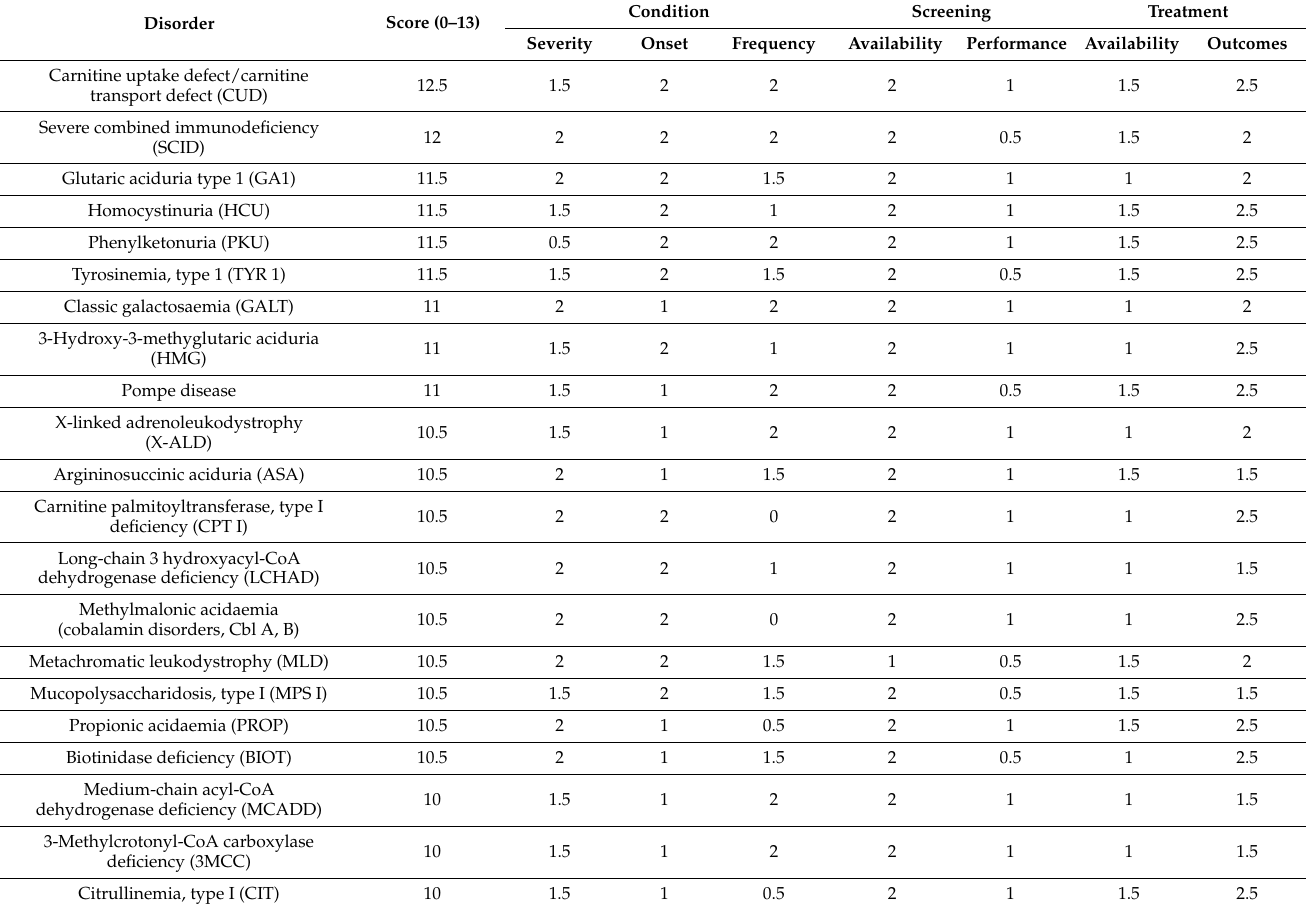
Table 1. Scoring of IMDs using the IMD NBS evaluation algorithm, ranked by highest to lowest score. Condition Screening Treatment Disorder Score (0–13) Severity Onset Frequency Availability Performance Availability